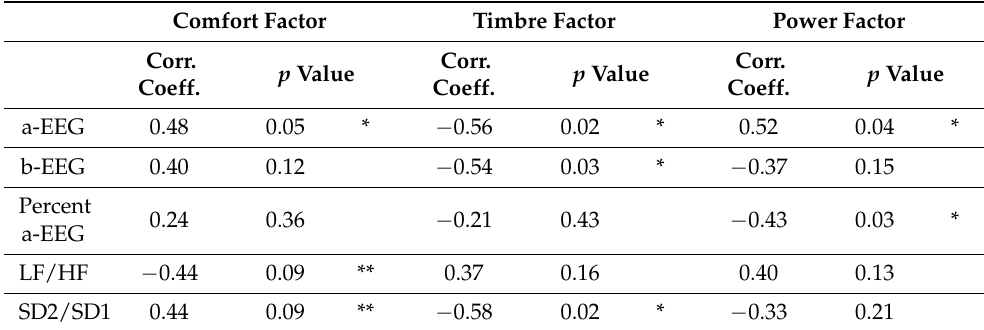
Table 3. Correlation coefficient between each subjective score and each biological parameter and p values of each correlation. Among each of the biological parameters, the α -EEG was mostly correlated with each subjective evaluation result. (*; p < 0.05, **; p < 0.1). Comfort Factor Timbre Factor Power Factor Corr. Corr. Corr. p Value p Value p Value Coeff. Coeff. Coeff. a-EEG 0.48 0.05 * − 0.56 0.02 * 0.52 0.04 * b-EEG 0.40 0.12 − 0.54 0.03 * − 0.37 0.15 Percent 0.24 0.36 − 0.21 0.43 − 0.43 0.03 * a-EEG LF/HF − 0.44 0.09 ** 0.37 0.16 0.40 0.13 SD2/SD1 0.44 0.09 ** − 0.58 0.02 − 0.33